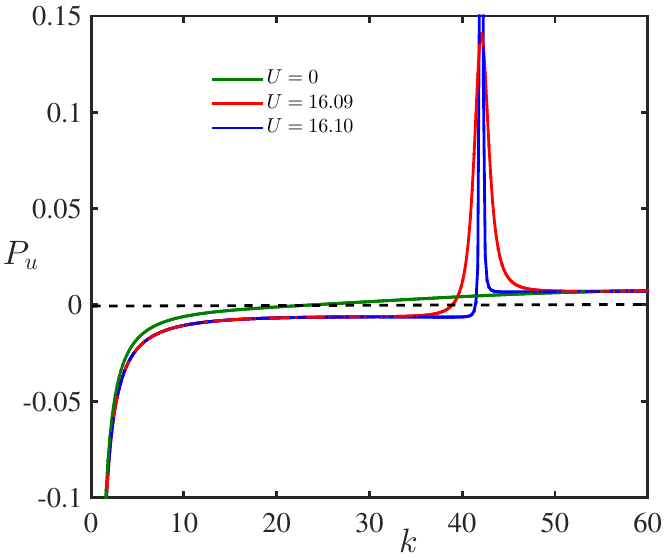
Figure 12. (Color online) Variation of the dispersion coefficient P u versus wavenumber k for different values of wind speed in the case of upper branch of dispersion curve.